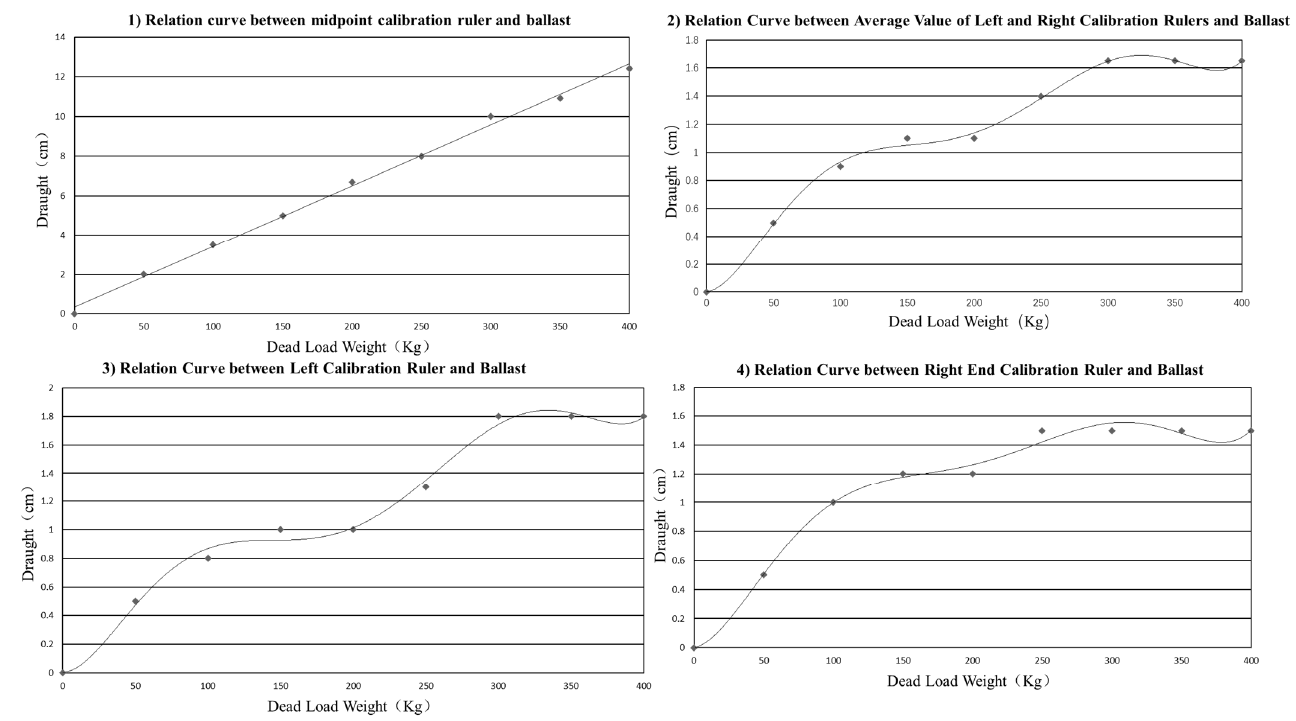
Figure 14. Relation curve between scale and ballast. Figure 15. Relation curve between scale and